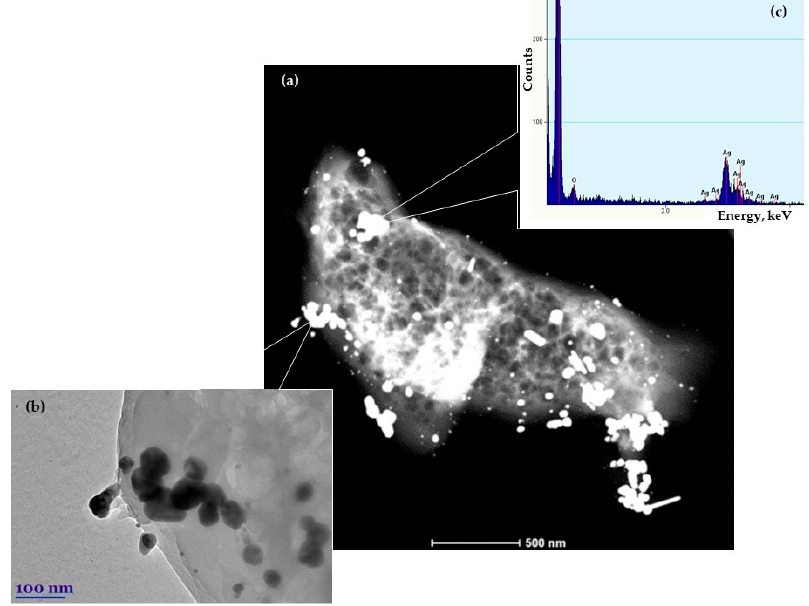
Figure 9. CF–Ag nanohybrid: ( a ) TEM image; ( b ) STEM image; ( c ) EDS spectrum.